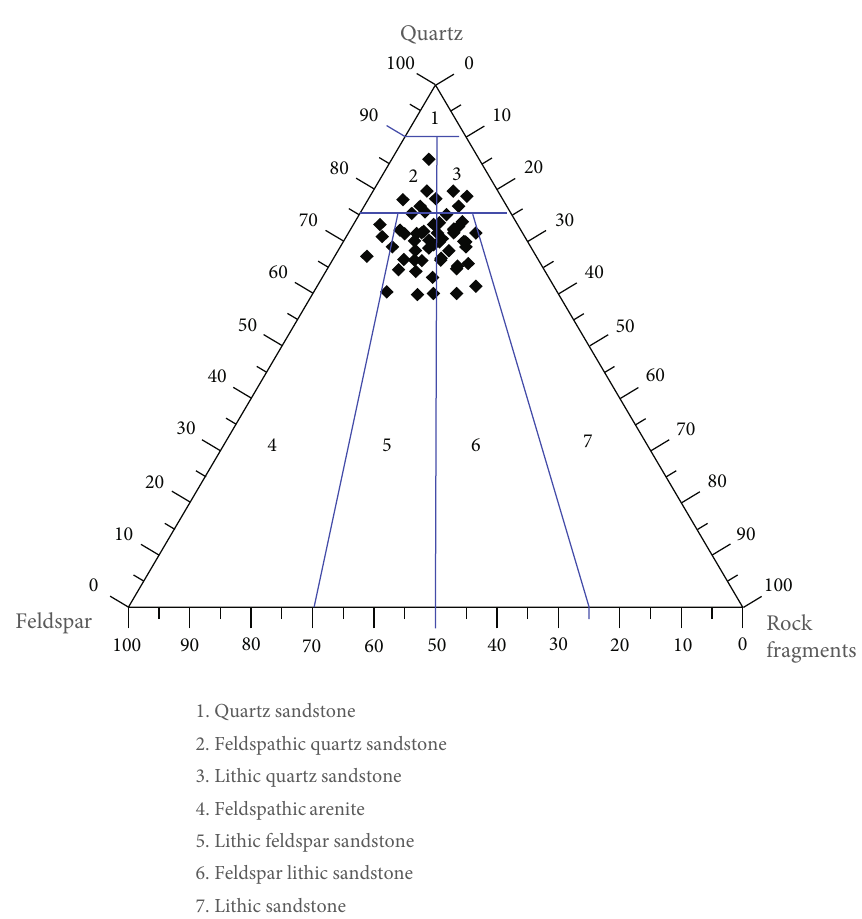
Figure 2: Triangle map of Paleogene sandstone composition in Yingmai 7 block.